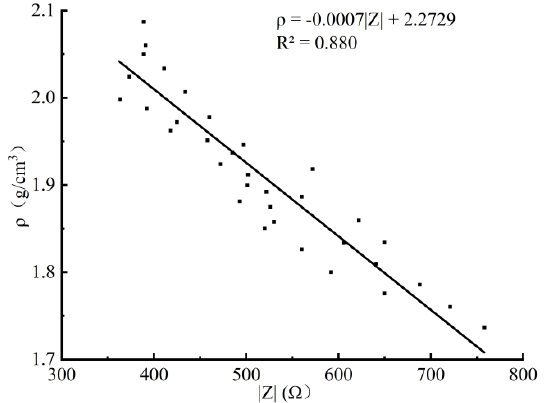
Figure 4. ρ -| Z | calibration equation (A7 group).